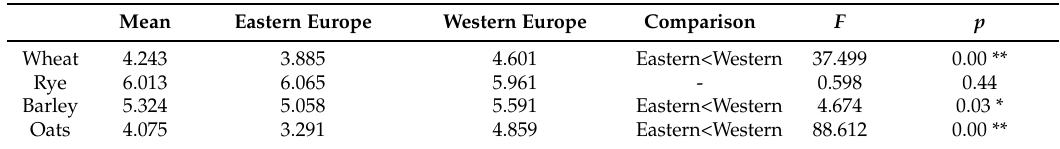
Table 1. ANOVA for various crop yield ratio between Eastern and Western Europe in AD 1700–1800. Mean Eastern Europe Western Europe Comparison F p Wheat 4.243 3.885 4.601 Eastern<Western 37.499 0.00 ** Rye 6.013 6.065 5.961 - 0.598 0.44